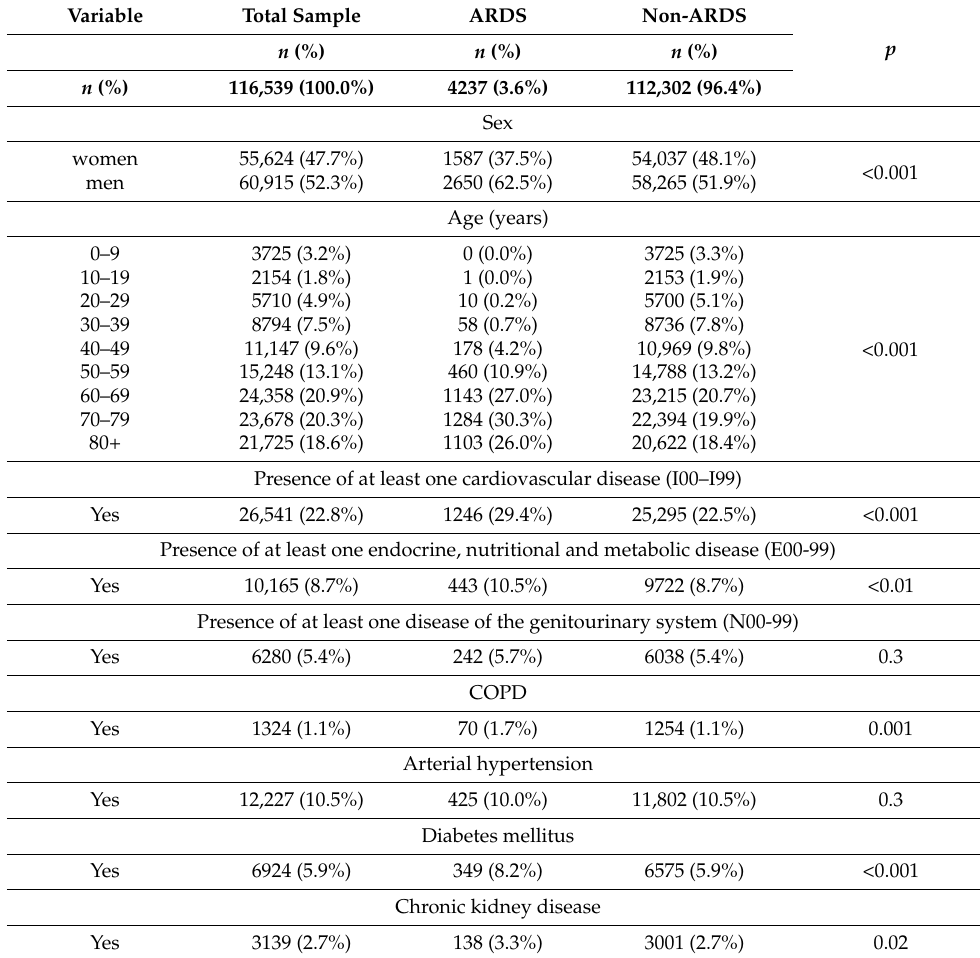
Table 1. The prevalence of ARDS among patients hospitalized with COVID-19, Poland,